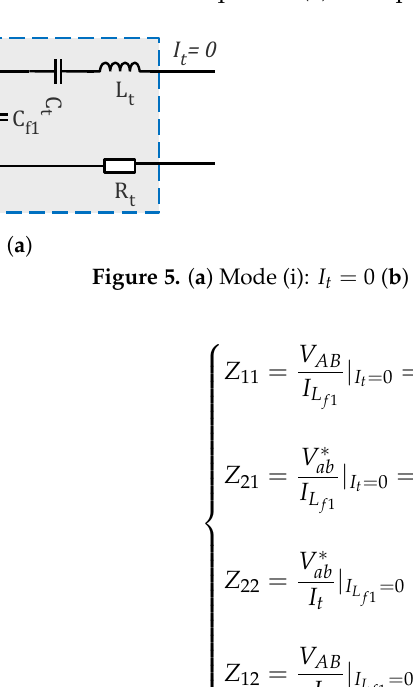
Figure 4. ( a ) Equivalent diagram of the proposed system, ( b ) voltage-driven two–port network of the proposed system. The system’s open-circuit impedance parameters are evaluated by considering the two operational modes as shown in Figure 5a,b. In mode (i), the output port is open-circuited = 0) . Considering these ( I t = 0), and in mode (ii), the input port is open-circuited ( I L f 1 two modes and Equation (5), the open-circuit impedance parameters are calculated as [33]